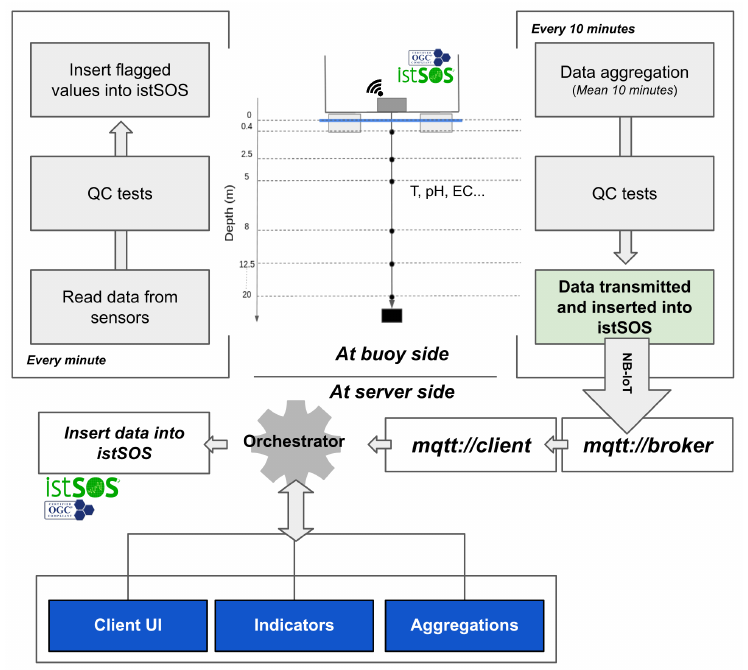
Figure 8. Data flow from buoy to